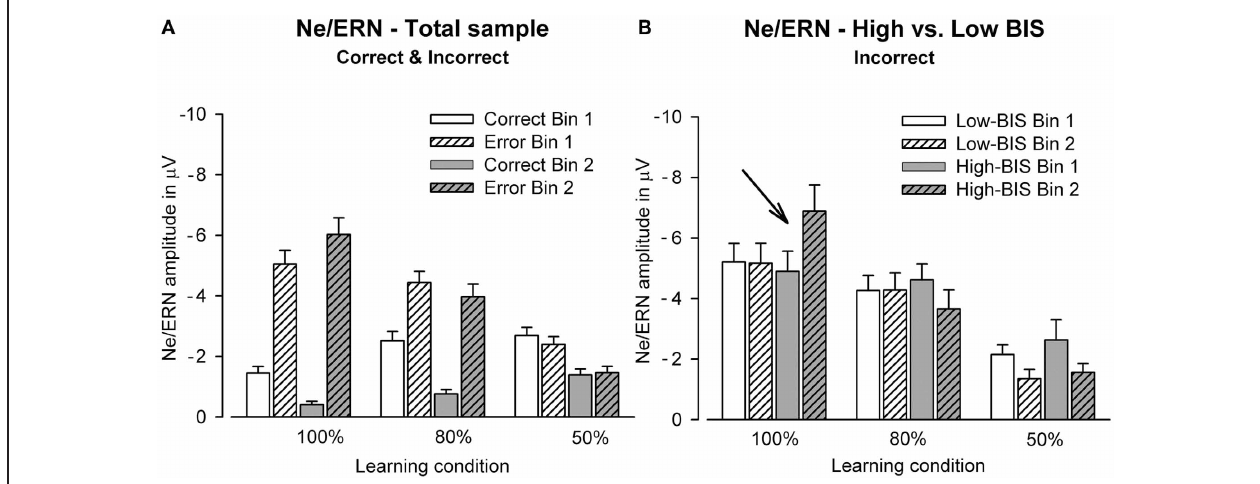
FIGURE 5 | Bar graphs show the amplitude of the Ne/ERN at FCz in Bin 1 and Bin 2 for (A) the total sample (error and correct trials) and (B) high vs. low BIS subjects (only error trials).